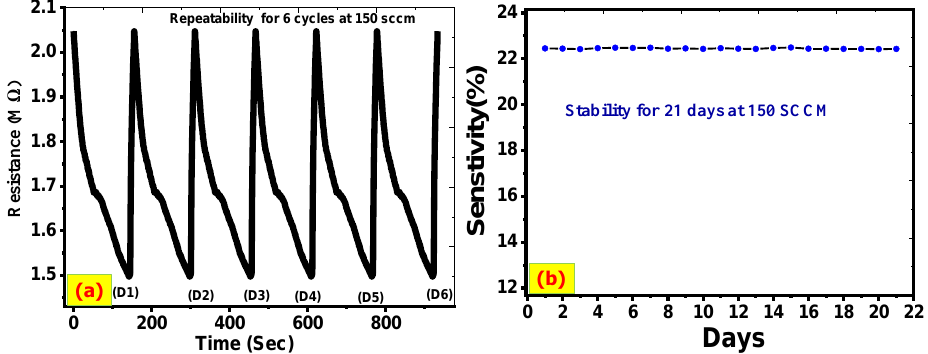
Figure 9. ( a ) Repeatability and ( b ) stability for ZnO/CNTs at 150 sccm CO 2 .